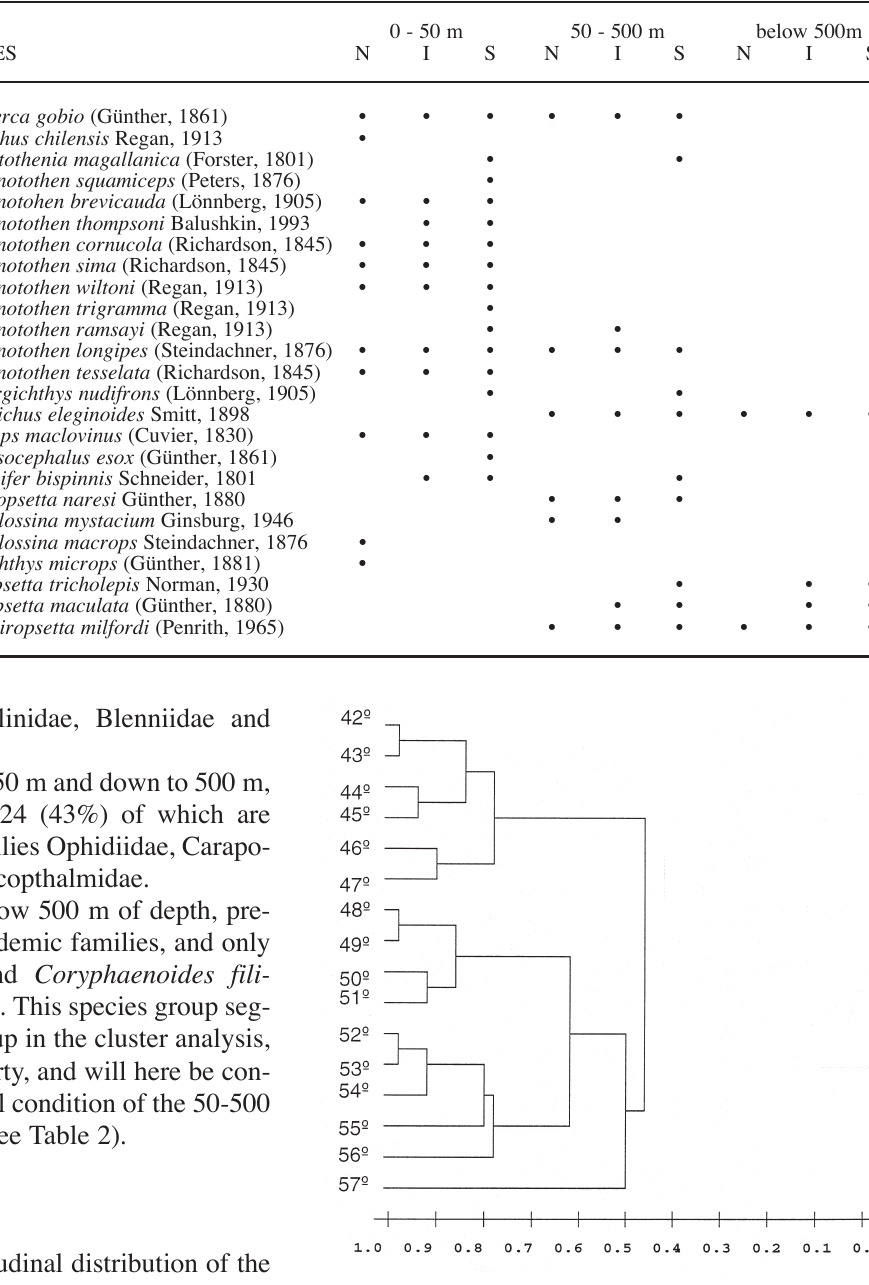
F IG . 3. – Taxocenotic similarity of latitudinal fish associations between 0 and 50 m depth, showing four major fish associations: 1.- 42 to 46ºS (northern sector), 2.- 47 to 51ºS (intermediate sector), 3.- 52 to 56ºS (southern sector), 4.- 57ºS (Diego Ramírez